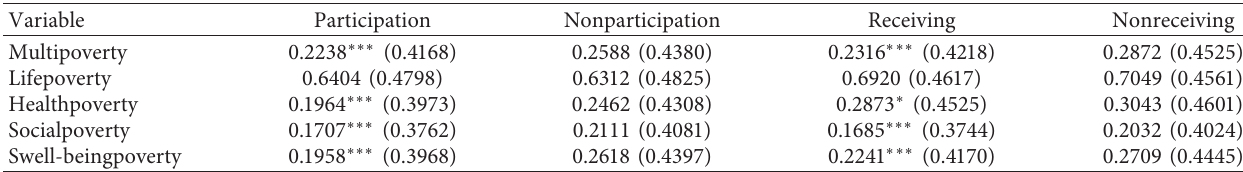
Table 3: Descriptive statistics of multidimensional poverty among the elderly in rural China.